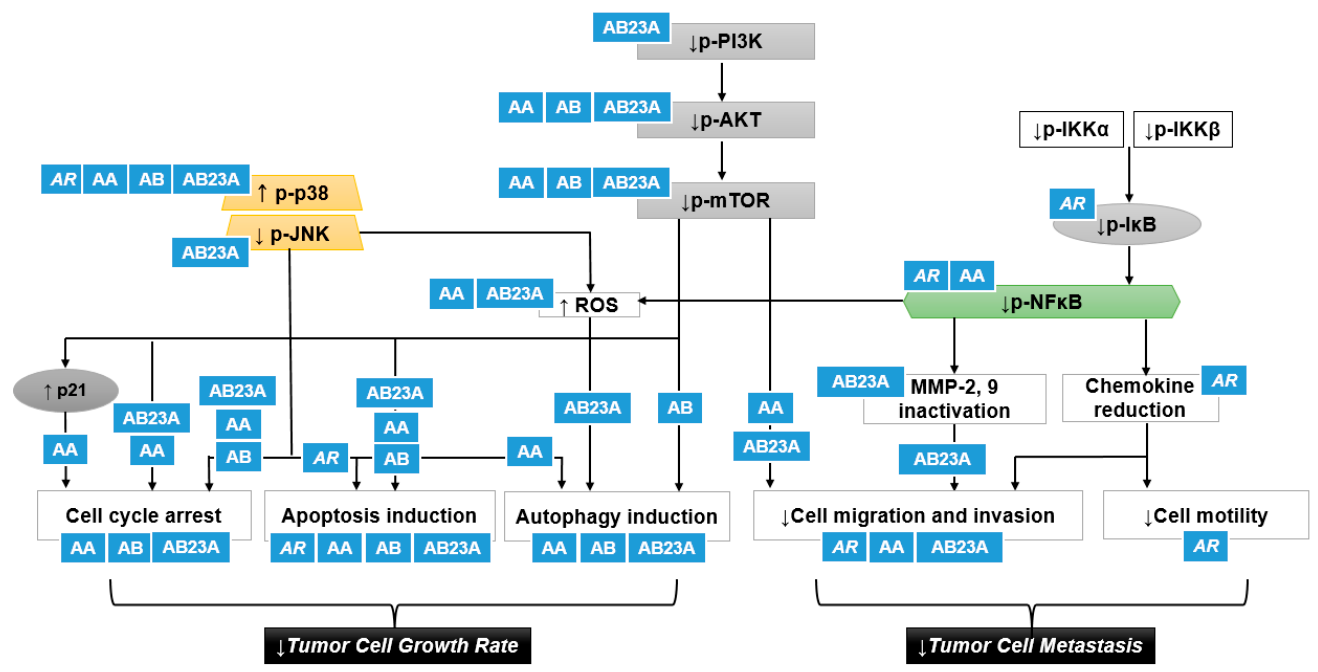
Figure 4. A putative scheme for t he p38 activation and PI3K/Akt/mTOR inhibition by AR and its triterpenes in suppressing cancer cell proliferation and tumor cell metastasis: AR , Alismatis rhizome : AA, alisol A; AB, alisol B; AB23A, alisol B 23-acetate; JNK, c-Jun N-terminal kinase; ROS, reactive oxygen species; IKK, I κ B kinase. Upward pointing arrows ( ↑ ) and downward pointing arrows ( ↓ ) indicate an increase or a decrease in an expression or production level, rate or degree, respectively.